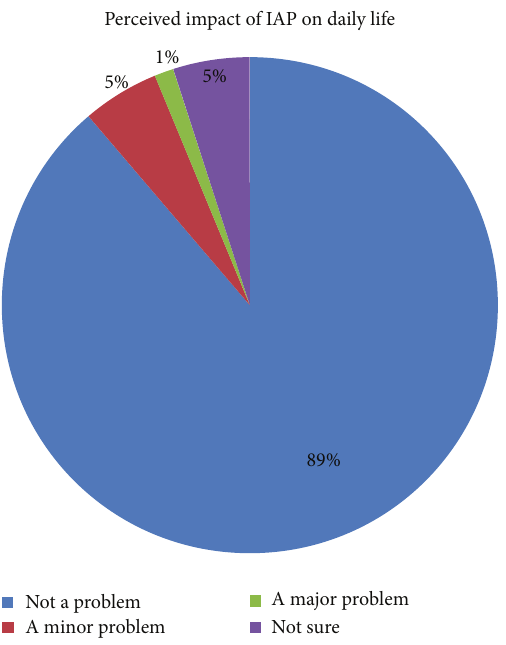
Figure 4: Perception of IAP as a health